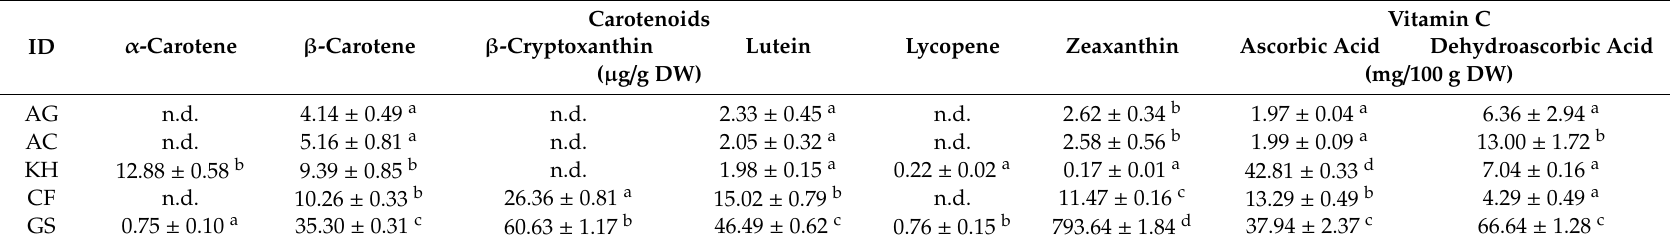
Table 4. Carotenoids and vitamin C in analysed dried fruits.